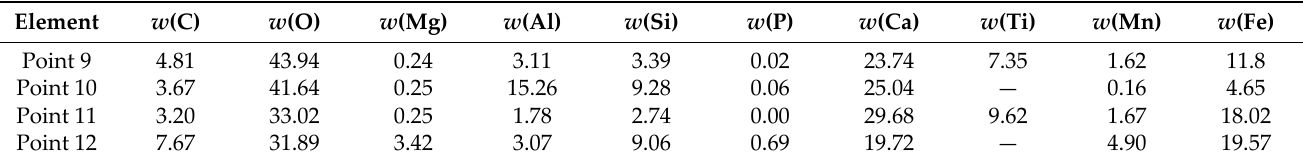
Table 5. Sr‑12 SEM point element distribution (mass fraction,